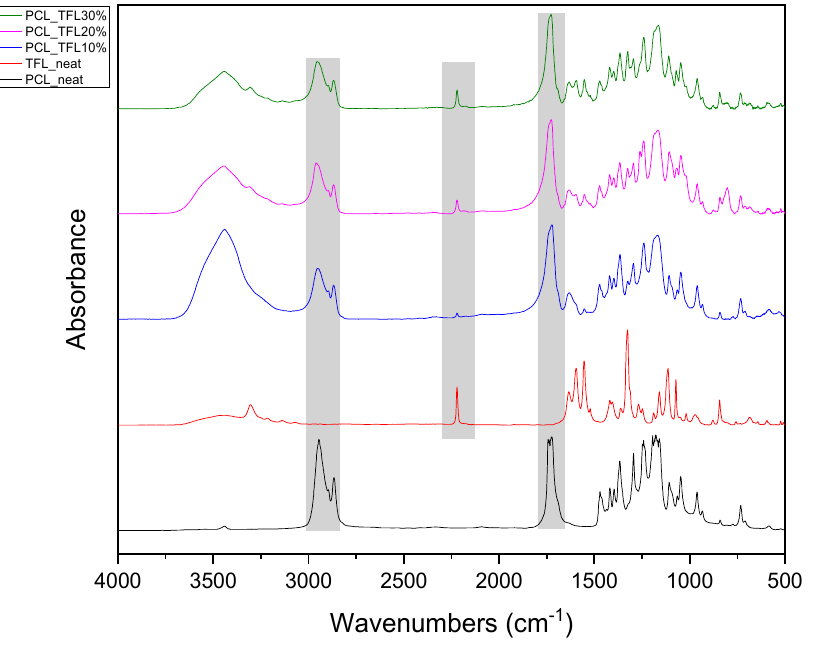
Figure 6. FT-IR spectra of neat PCL, neat teriflunomide and drug-loaded electrospun mats.